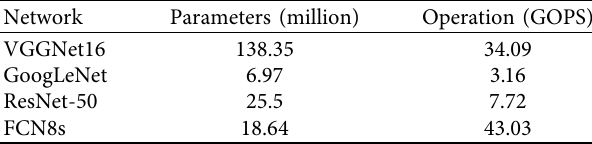
Table 1: Characteristics of compute-intensive